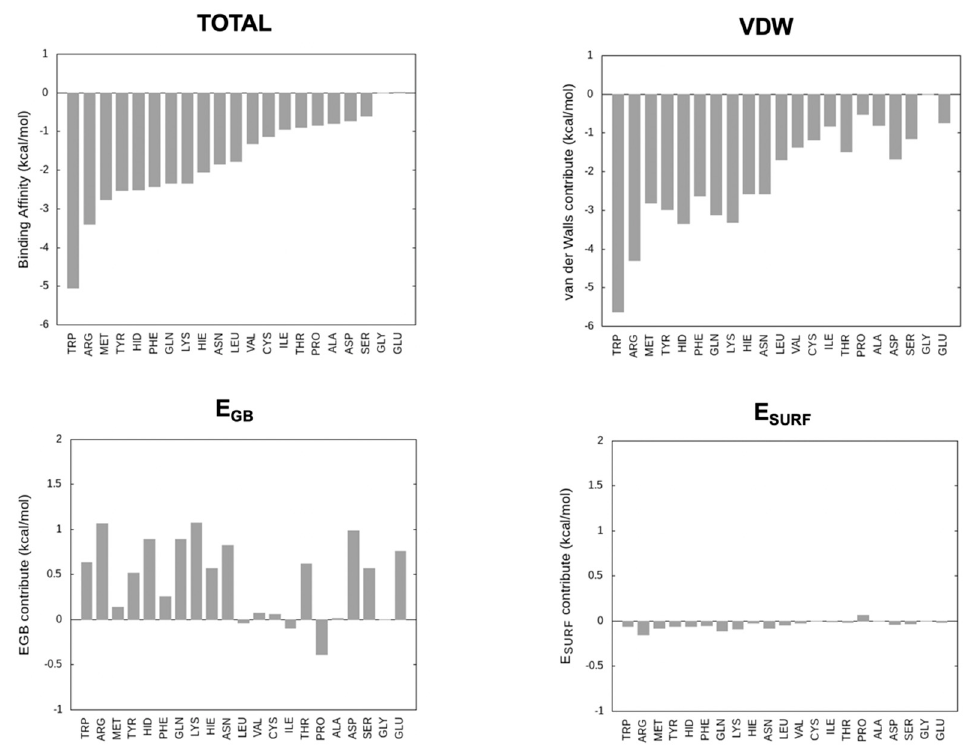
Figure 2. Analysis of the components of the binding energy of the amino acid side chains by MM/GBSA.